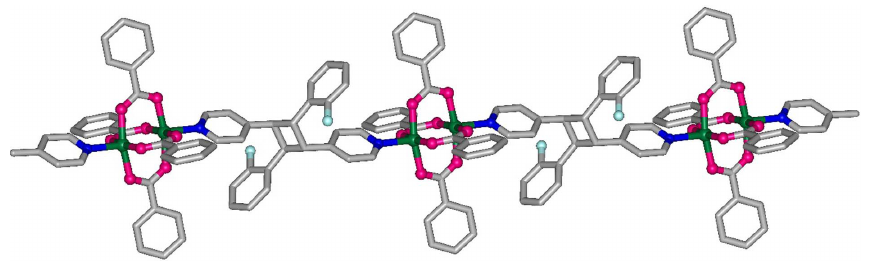
Figure 2 Perspective view of the photoproduct 5A showing the formation of the one-dimensional coordination polymer. Hydrogen atoms have been omitted for